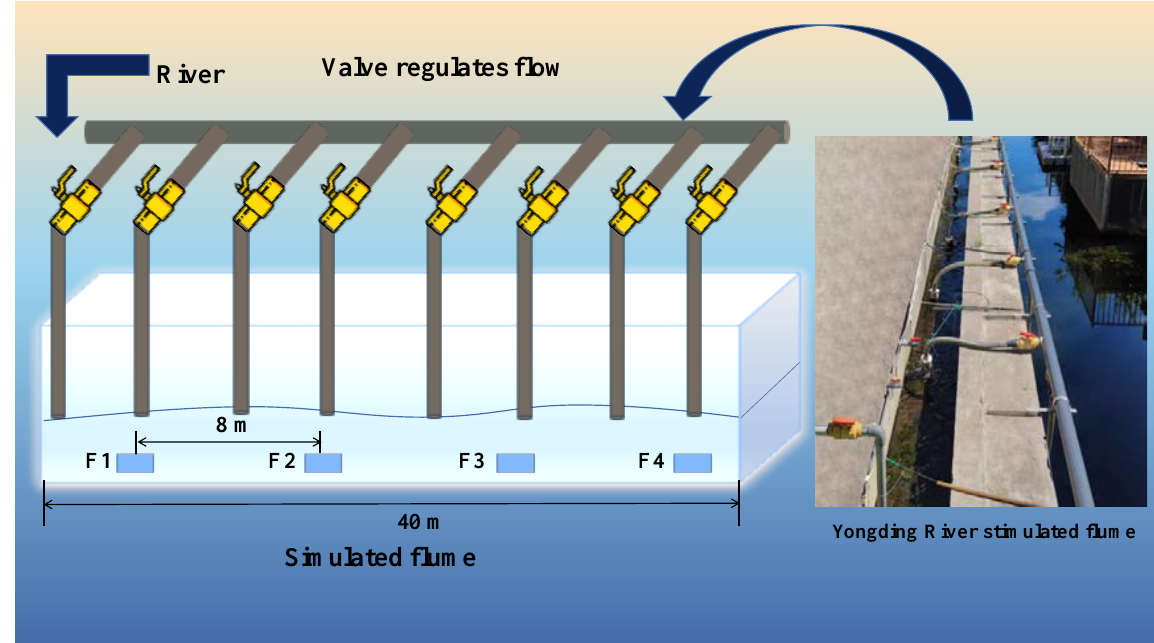
Figure 1. Schematic diagram of the experimental water tank.